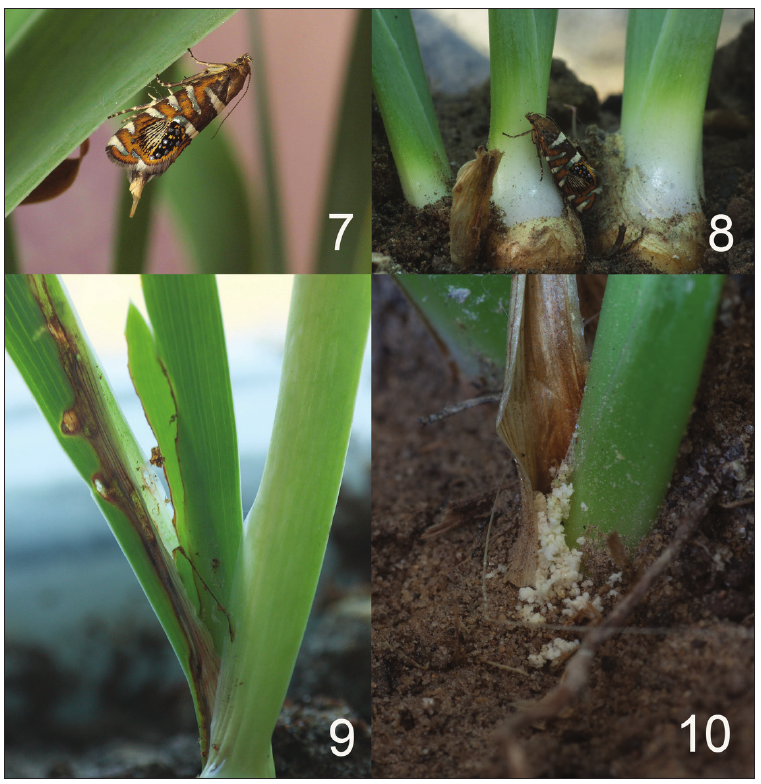
Figures 7–10. 7. Female releasing sex pheromone, 17.v.2013, Törökbálint 8. Ovipositing Female, 18.v.2013, Budapest 9. Leafmine in Iris × germanica , 18.vi.2013, Budapest 10. Larva pushing excrements out of rhizome of Iris , 01.vii.2013, Budapest. Photos by Attila